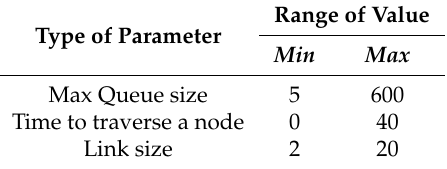
Table 1. The range of value of three types of parameters codified in the genetic